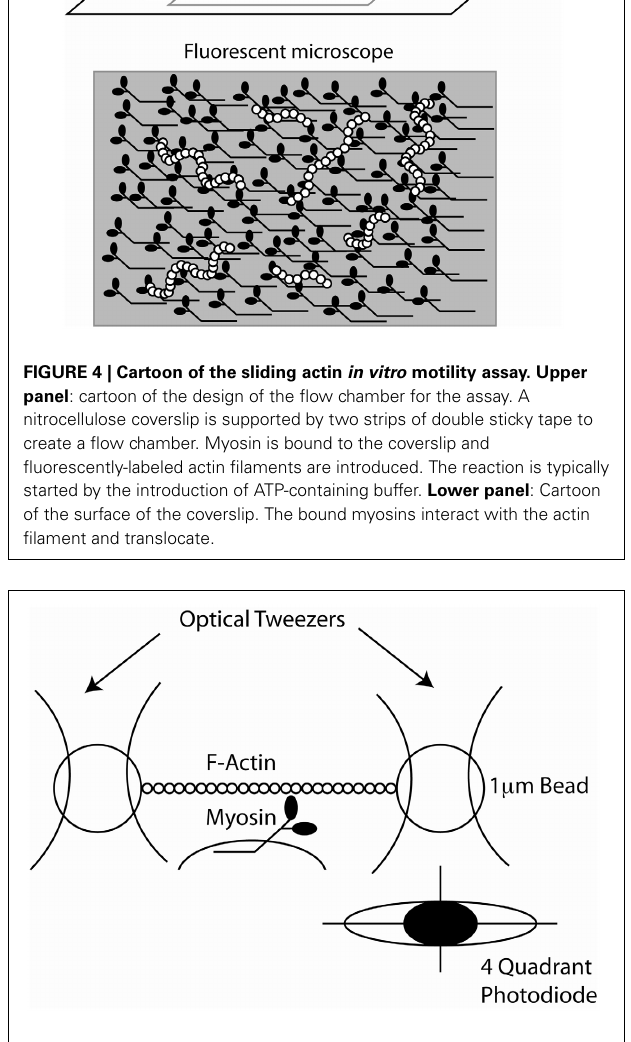
FIGURE 5 | Cartoon of the design of the three bead optical trap. Two separate focused laser beams create two optical traps (tweezers). Each trap has a captured bead and there is an actin filament that is bound at each of its end to one of the beads. A single myosin molecule is bound to a bead on the surface of the coverslip. The image of one of the beads is shown to be focused on a quandrant photodiode which detects its position with nanometer accuracy.